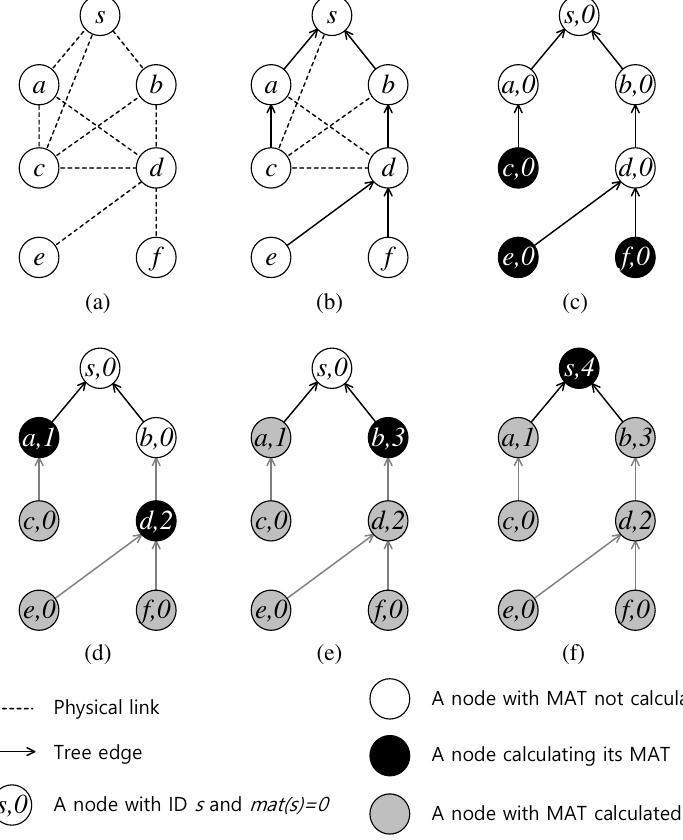
Figure 5. Step-by-step calculation of Minimum Aggregation Time on each